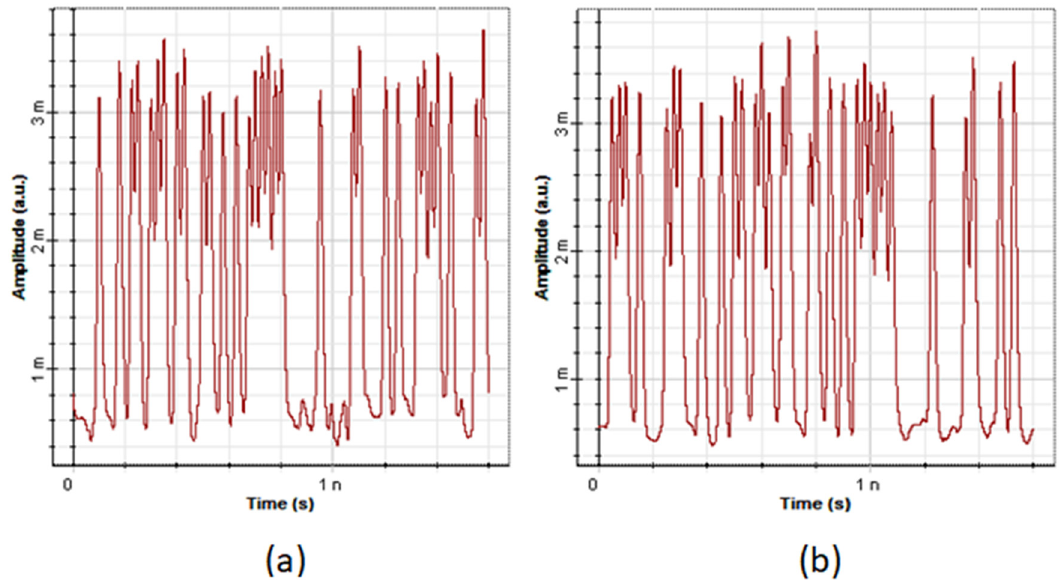
Figure 9: Amplitude vs time directly after Photodetector ( PIN ) at the side receiver for output drop: ( a ) signal_1 = 193.1 THz and (